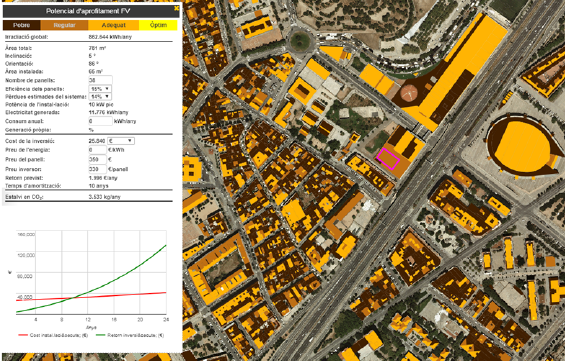
Figure 8. Suitability index for the deployment of photovoltaic energy facilities